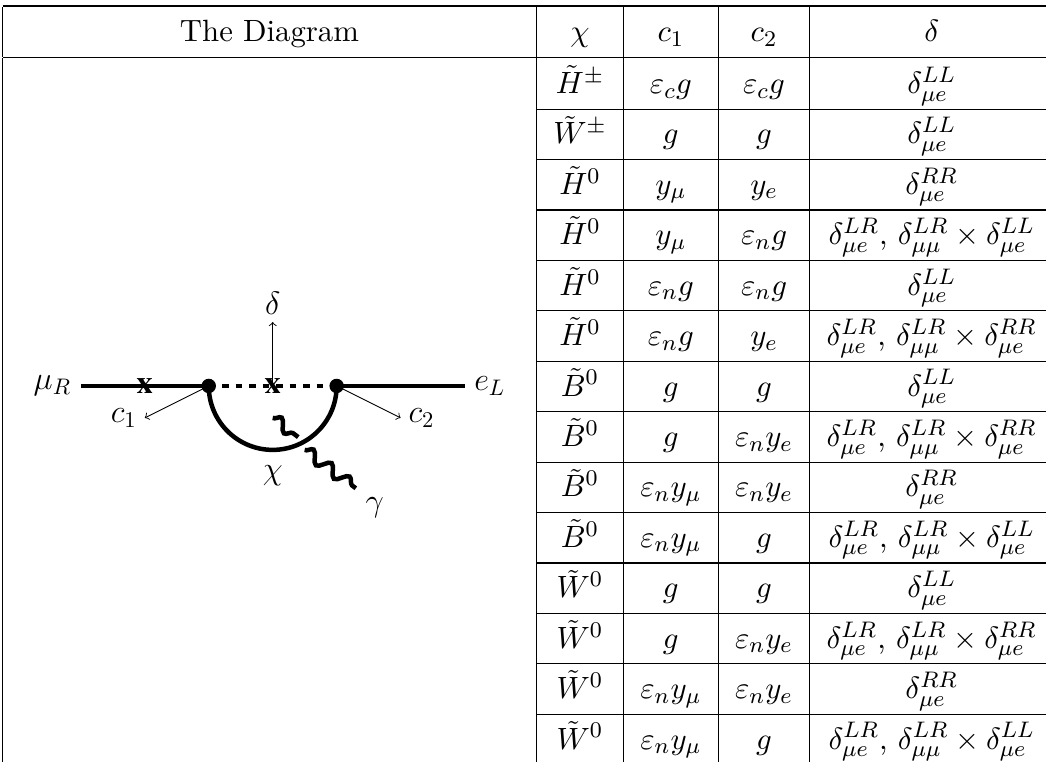
that come Table 5 . Diagrams with sleptons and gauginos/higgsinos in the loop contributing to c R 21 from the y term in eq. (A.2). This Wilson coefficient contributes to LFV observables such as L y L BR ( µ → eγ ) . The general topology of the diagram is shown on left. The second column shows the gaugino or the higgsino in the loop. The SM couplings appearing in each vertex, as well as ε s that characterize neutralino or chargino mixings, are shown in the next two columns. We consider all possible combinations of couplings with all possible fermions and sleptons in the loop. The last column includes the δ insertions on the slepton propagator. We are only including diagrams with the fewest number of δ insertions and at most one δ LR entry. These δ insertions are the source of LFV in our setup. As evident from the table, the diagrams with a Bino or a Wino in the loop and no chirality flip on the propagator dominate, while other diagrams have more suppression thanks to fermion mixings ε , the SM yukawas, or a δ LR insertion on the slepton n/c